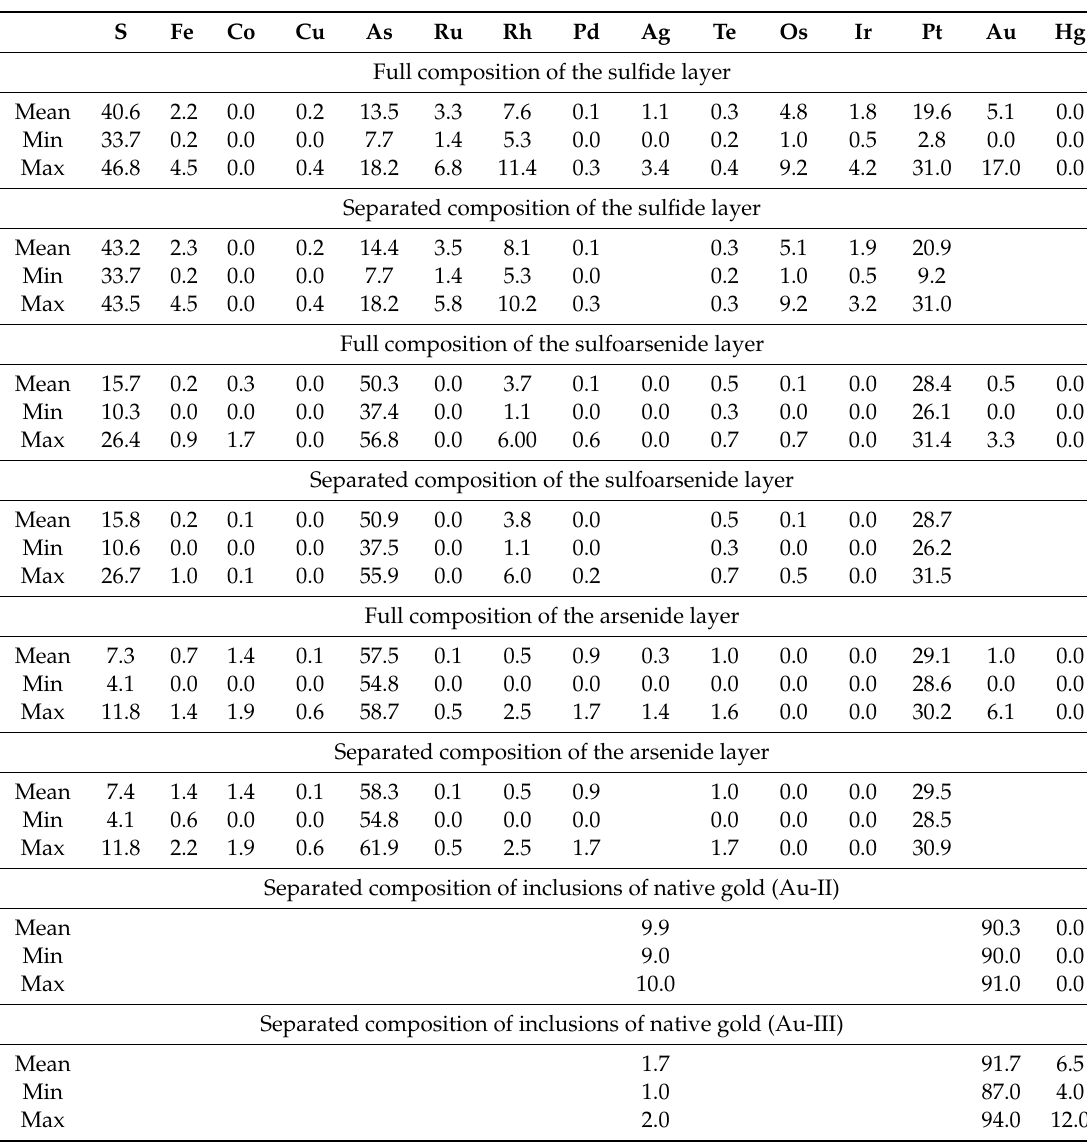
Table 9. Full and “separated” chemical composition